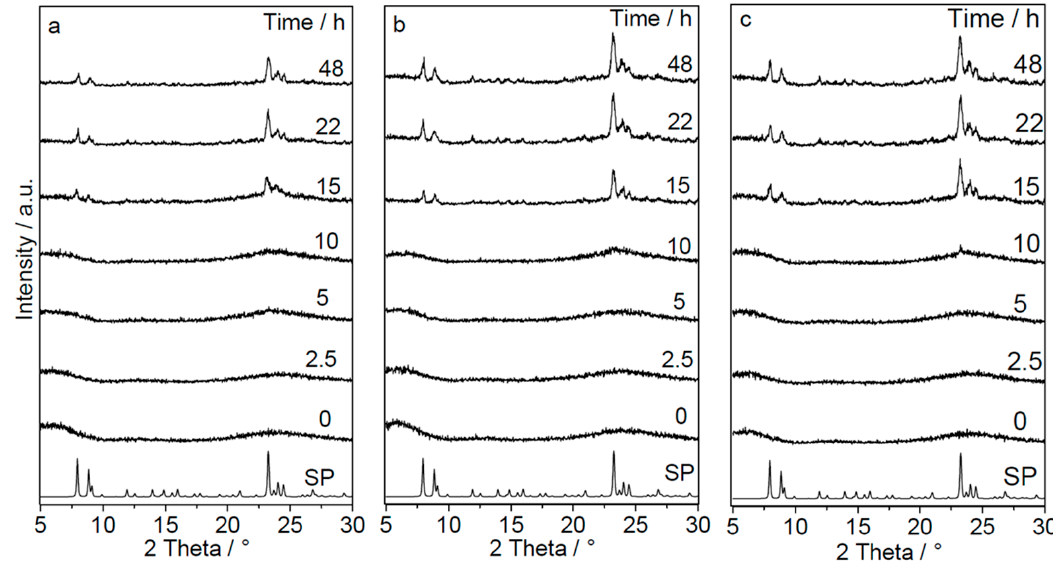
Figure 1. X-ray diffraction patterns of dried suspensions collected after different times of hydrothermal synthesis. The starting gels (0 h) were aged for 1 h ( a ), 24 h ( b ) and 96 h ( c ). The suspensions from hydrothermal synthesis were dried at 90 ◦ C for 16 h in an oven without stirring. SP is the simulated pattern of MFI-type zeolite. These patterns show that the formation of MFI phase increases with the aging time of the starting